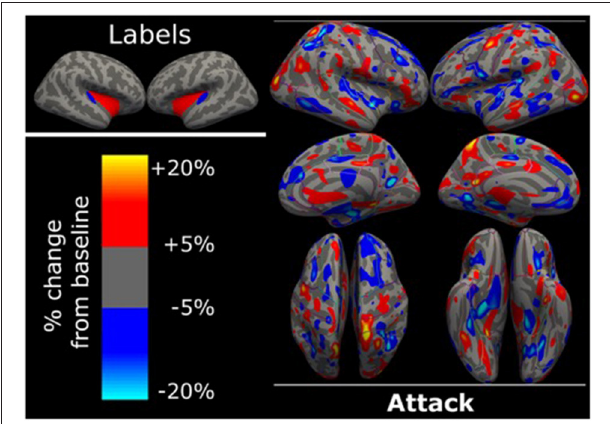
FIGURE 1 | Surface based analysis. Surface based analysis in FreeSurfer showing percentage changes of 18 F-FDG uptake during MD attack compared to the patient’s own baseline 18 F-FDG scan. There were no significant changes of more than 20% change between the 18 F-FDG uptake during MD attack compared to the patient’s own baseline scan obtain 7 days later. Labels for anatomical orientation are shown in the upper left corner. Blue is Heschl’s gyrus, red is insula, as defined by the Desikan-Killeany atlas. Dark gray is sulci, light gray is